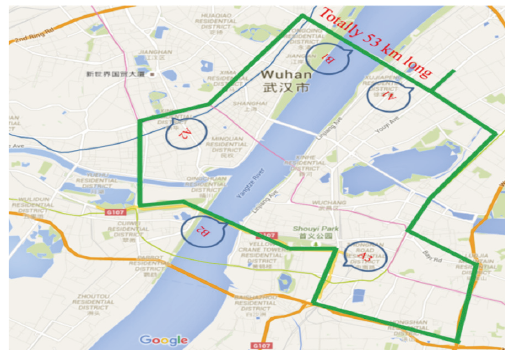
Figure 10: The test route.